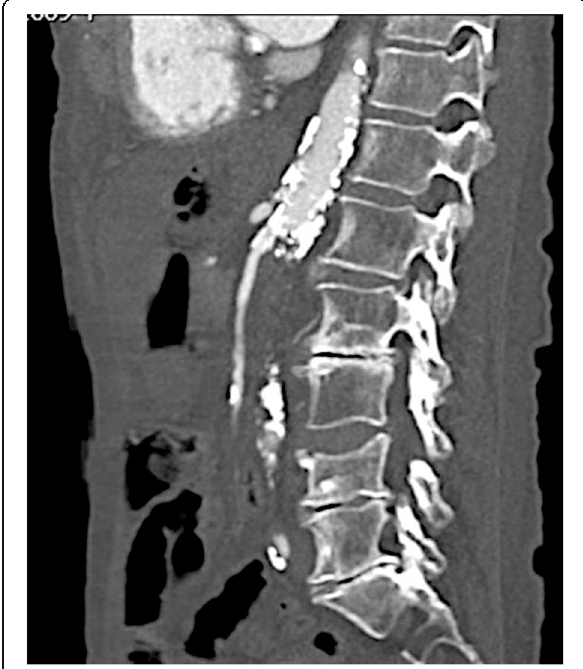
Fig. 5 Follow-up CT of the abdomen 13 months after revascularization and stenting of the SMA with free perfusion of the